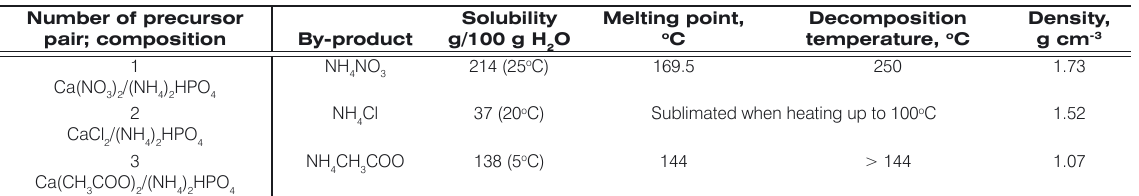
Table 1. Sample notations, composition and properties of the by-products Number of precursor pair; composition